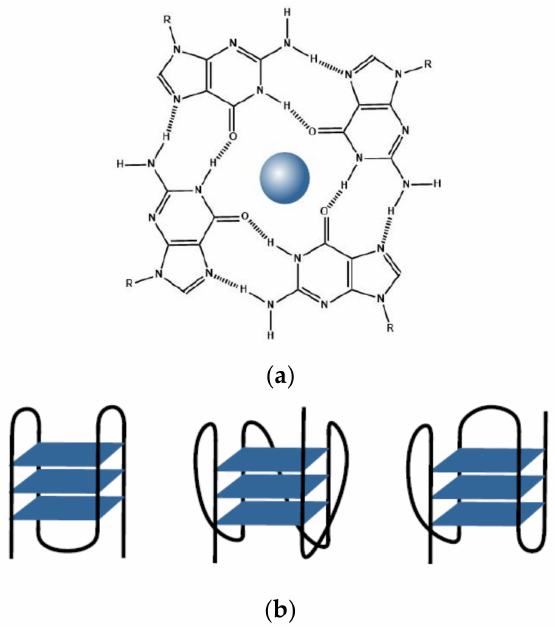
Figure 1. ( a ) Structure of a G-quartet with a coordinated ion; ( b ) Schematic representation of antiparallel, parallel, and hybrid intramolecular G-quadruplexes.